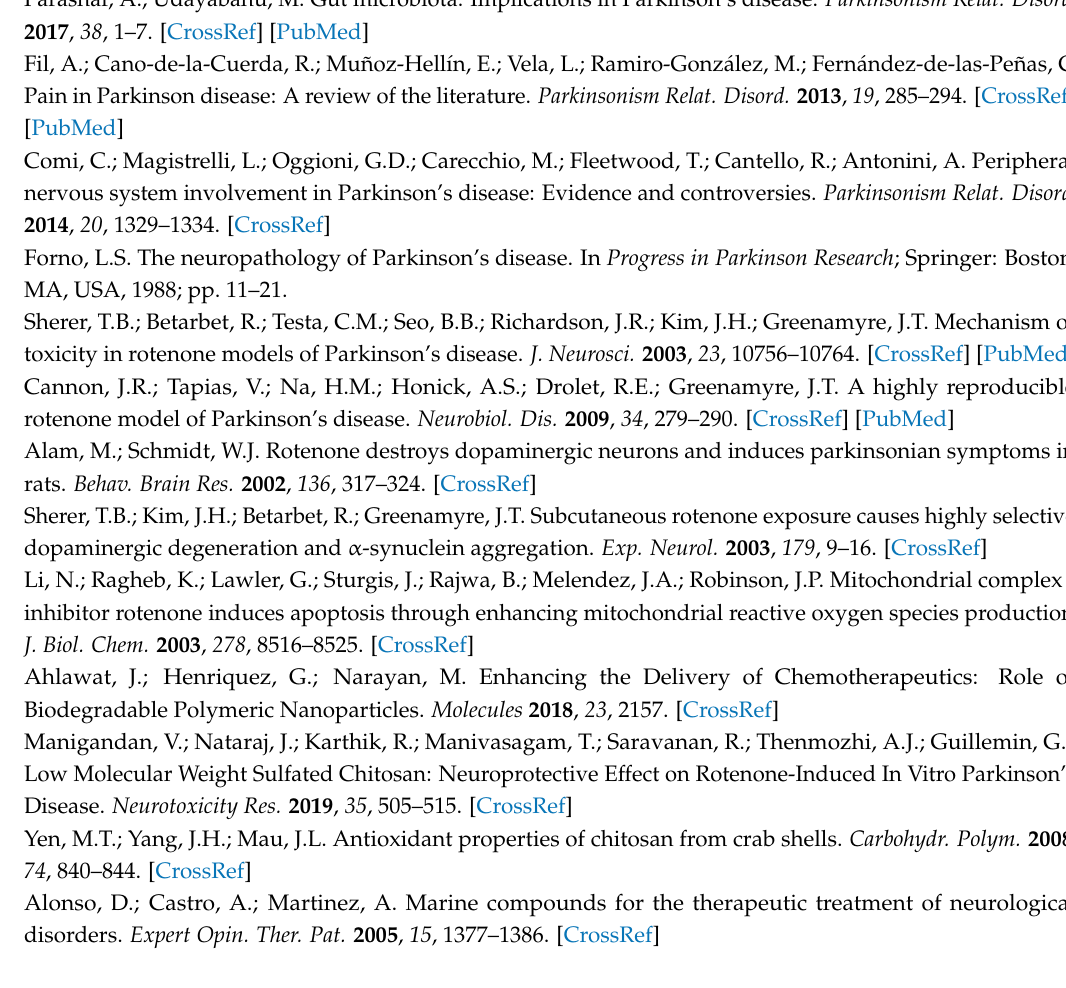
s1, Figure S1: SEM image of Chitosan nanoparticles in buffer solution, Figure S2: Size distribution analysis from AFM